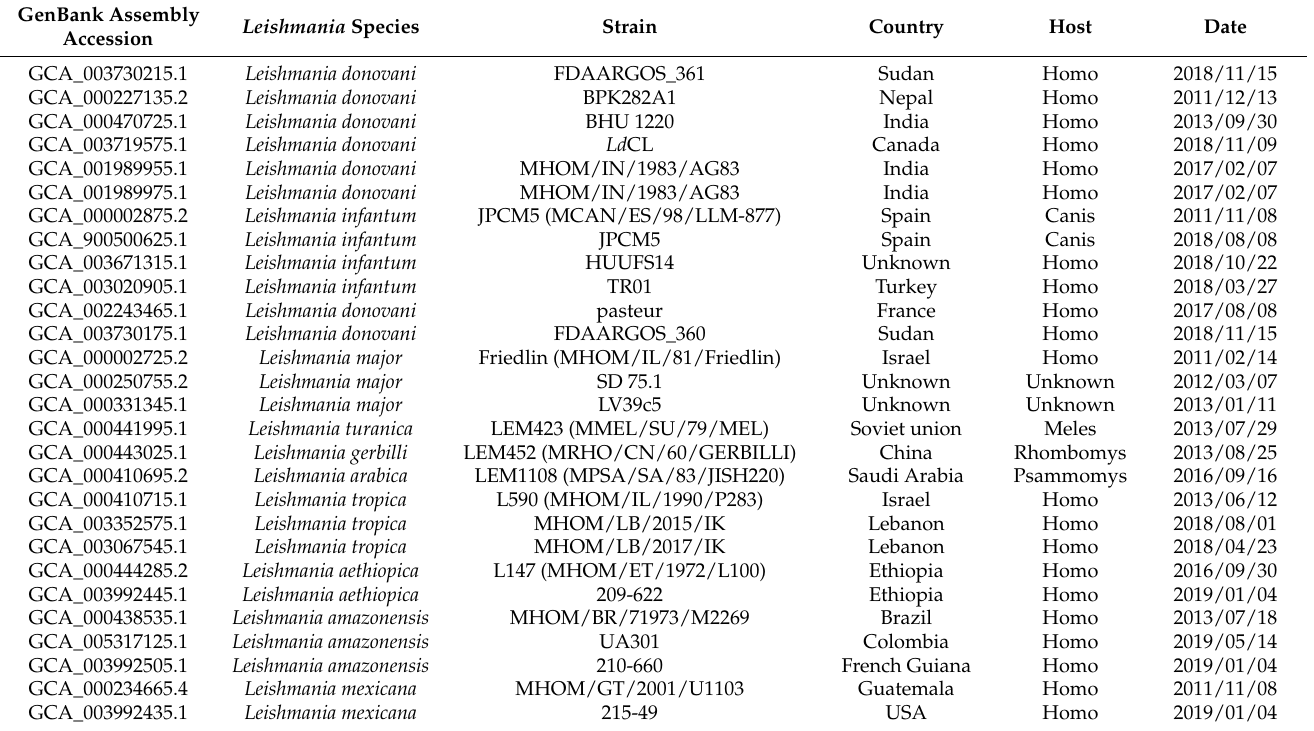
Table 2. Whole-genome sequence information of Leishmania strains downloaded from